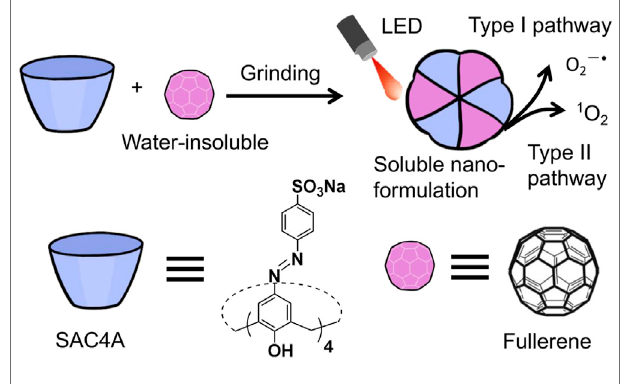
FIGURE 1 | Schematic illustration of supramolecular nanoformulation formed by the host – guest complexation between SAC4A and fullerene. The encapsulation of fullerene with SAC4A gives rise to improved solubility and ef fi ciently activated ROS.